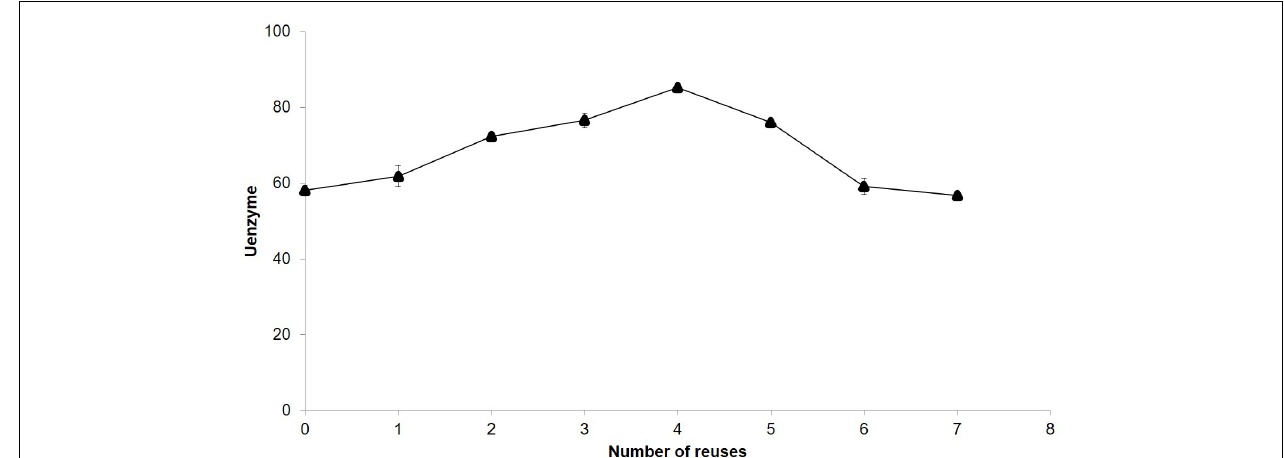
FIGURE 2 | Reusability of immobilised β